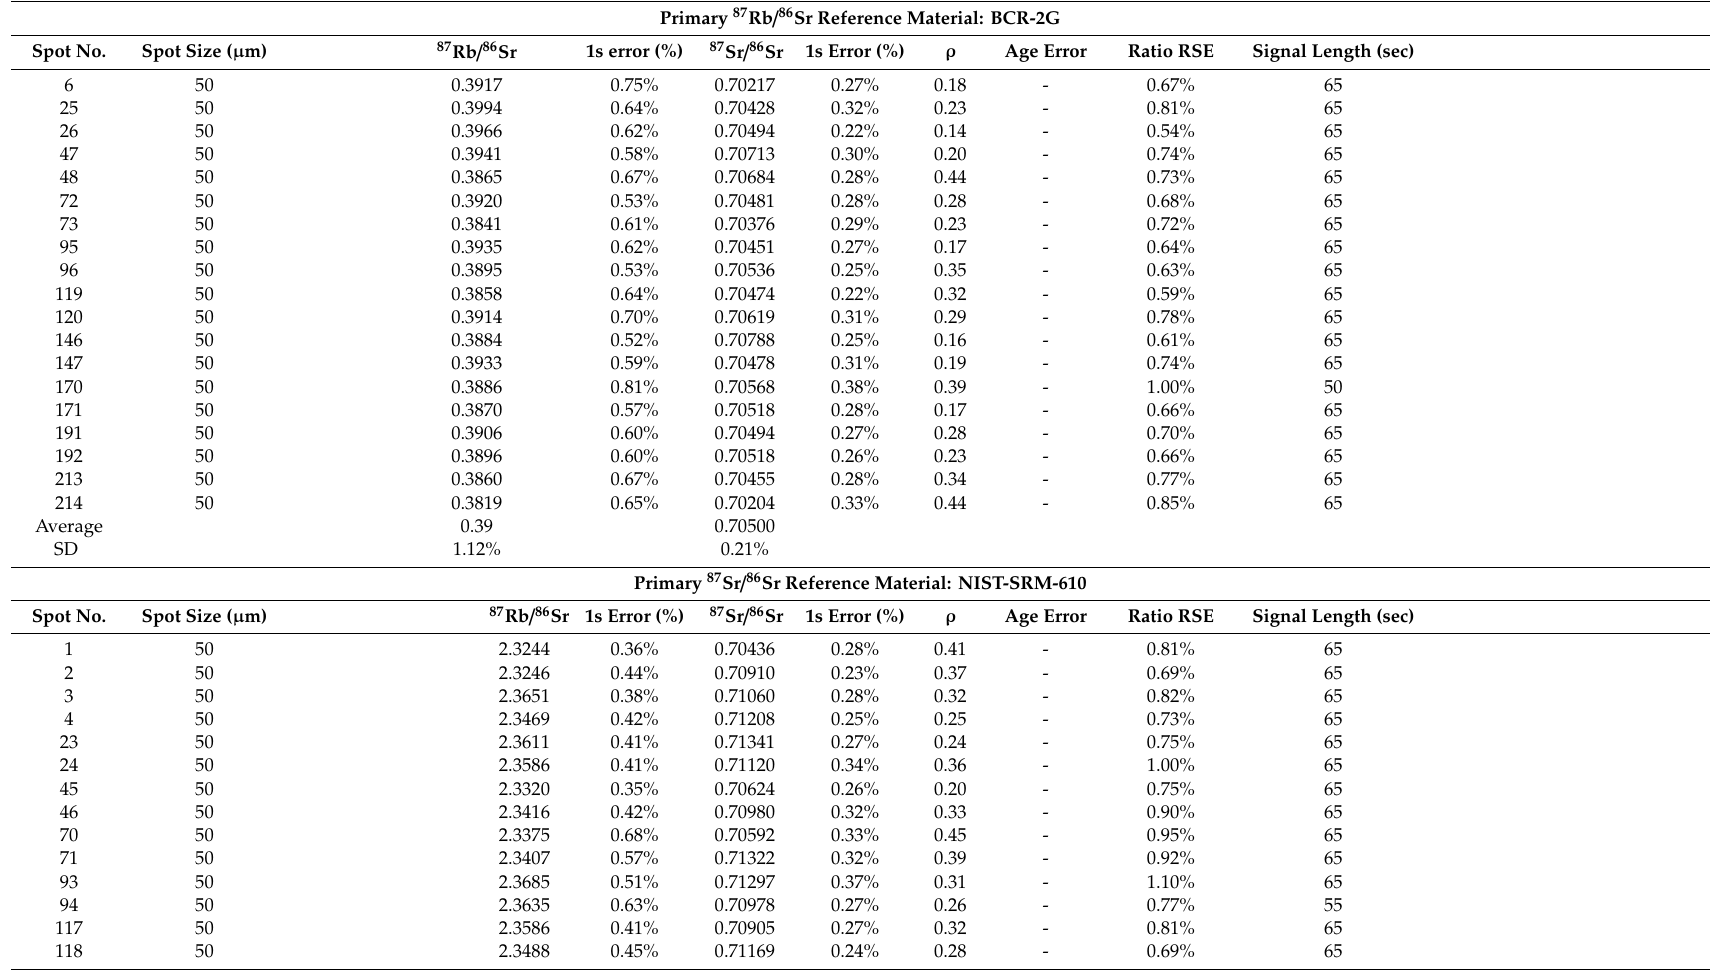
Table 3. LA-ICP-MS in situ Rb-Sr data of reference